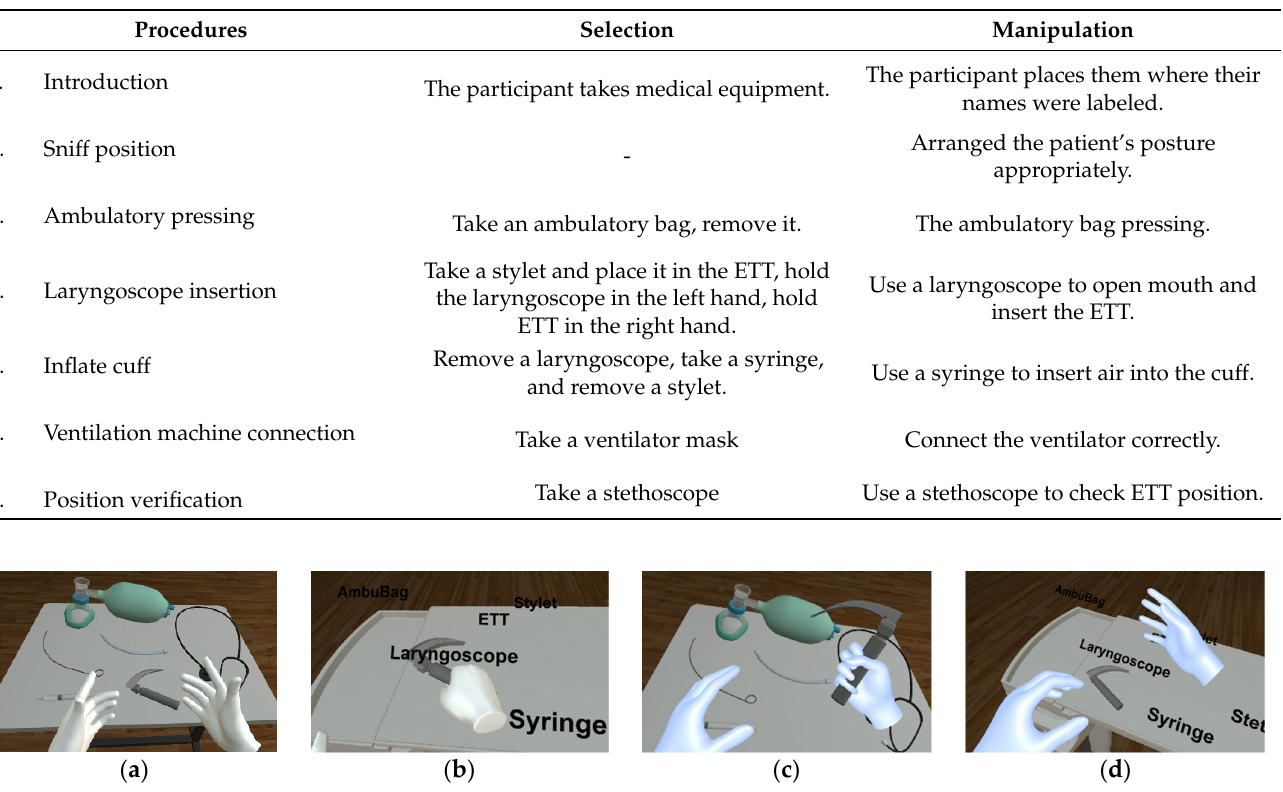
Table 3. Interactions of each procedure in VR intubation training.